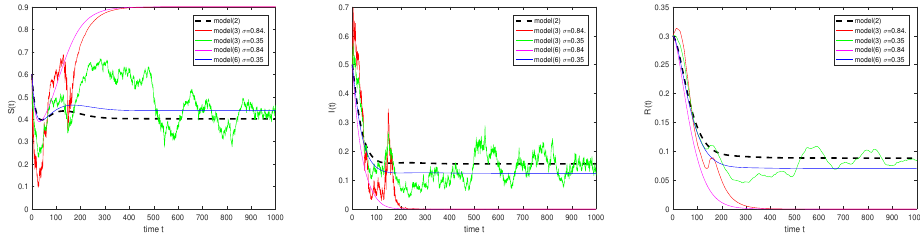
Figure 1. The paths of S ( t ) , I ( t ) , and R ( t ) under the initial value ( S ( 0 ) , I ( 0 ) , R ( 0 )) = ( 0.6,0.5,0.3 ) . Example 2. Take the initial value ( S ( 0 ) , I ( 0 ) , R ( 0 )) = ( 0.6, 0.3, 0.5 ) , and parameters ψ = 0.11 , η = 0.54 , µ = 0.05 , φ = 0.2 , κ = 0.09 and σ = 0.2 . The time step size ∆ t = 0.01 . Through = 1.5294 > 1 , and K − B / µ = 0 . Based the calculation, we have R 0 = 1.5882 > 1 , R m 0